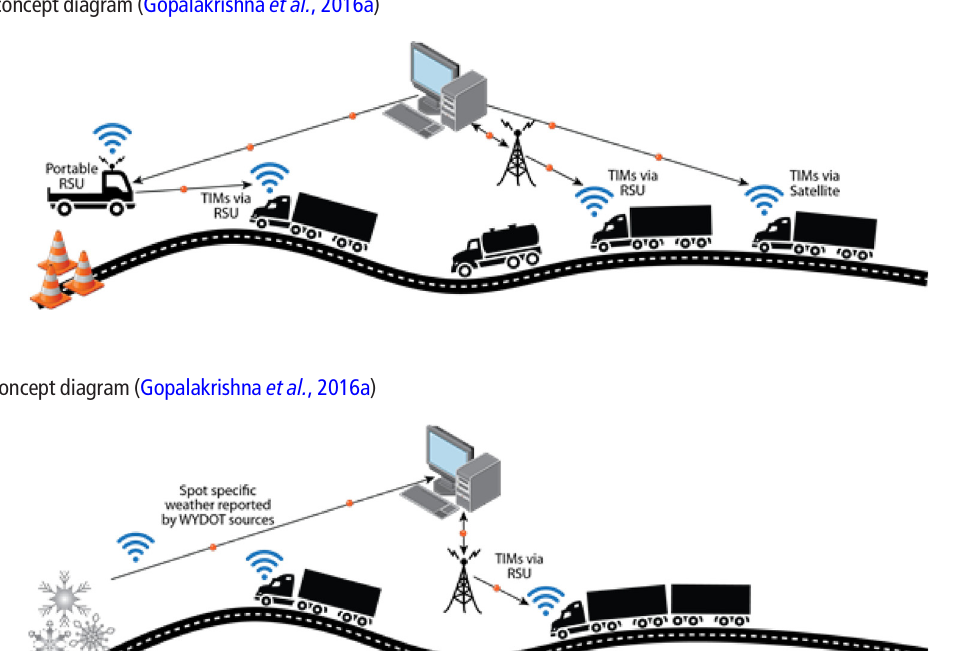
Figure 6 WZWs concept diagram (Gopalakrishna et al. , 2016a)